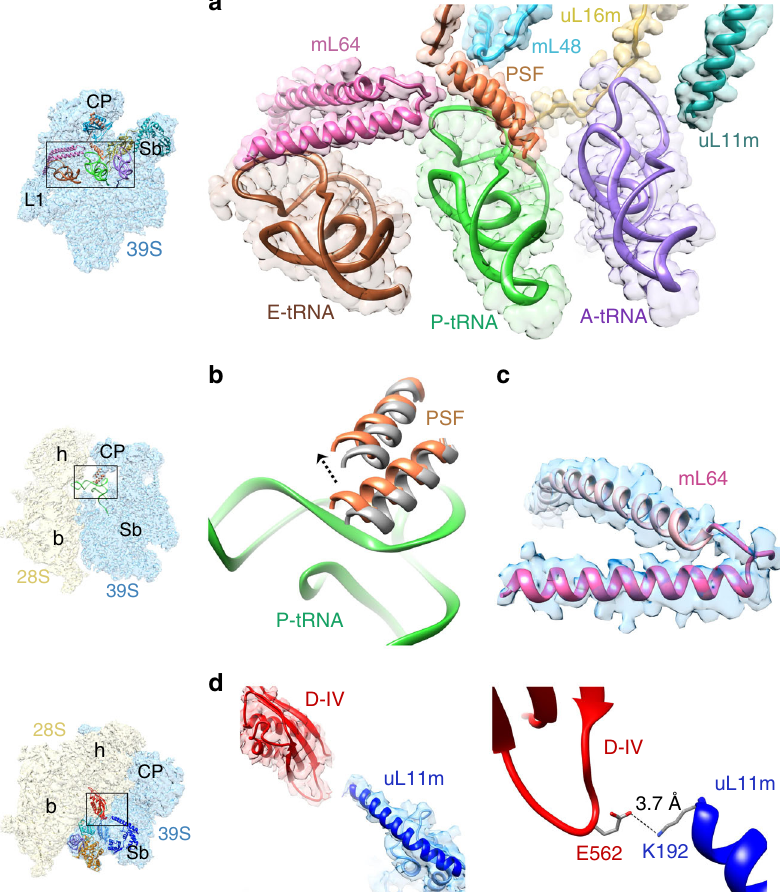
Fig. 4 Interactions of tRNAs mt and EF-G1 mt with mito-speci fi c proteins and mito-speci fi c segments in homologous proteins. a Interactions of the A (purple), P (green), and E (brown) tRNAs mt with mito-speci fi c proteins, PSF (orange), mL48 (blue), mL64 (pink), and mito-speci fi c insertion/extension to homologous proteins uL11m (dark cyan) and uL16m (yellow). The A-site tRNA mt position in its A/A state is derived from the 55S bovine ( Bos taurus ) map (see Supplementary Fig. 8). b Dynamics of PSF, which has moved by ~4 Å towards the P-site tRNA while interacting with the D and T loop regions P-site tRNA (P/P state) in the 55S·EF-G mt ·GMPPCP complex, from its position in the vacant human mitoribosome (gray) 2 . c Structure of the C-terminal region (A160-E192, darker pink) of mL64 derived from Class III map (blue). d Interaction between the mito-speci fi c segment of uL11m (dark blue) with the domain IV of EF-G1 mt (red), involving a hydrogen-bond between uL11m ’ s C-terminal residue K192 and E562 from domain IV. Thumbnails to the left of panels a , b , and d depict overall orientation of the 39S and 55S mitoribosomes. Landmarks on thumbnails: CP central protuberance, L1 uL1m stalk, Sb uL11m stalk base of the 39S LSU, h head, b body of the 28S